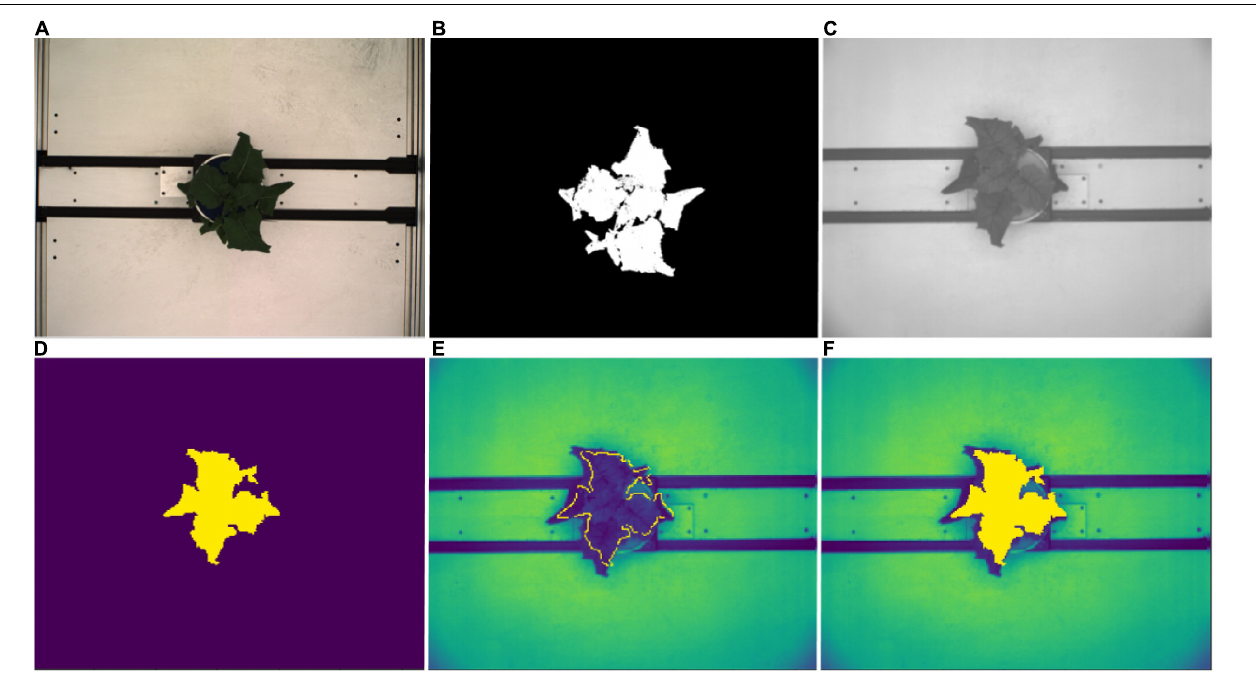
FIGURE 3 | NIR image processing workflow. (A) Top view RGB image. (B) Corresponding image segmentation resulting from workflow described in Figure 2 . (C) Original top view NIR grayscale image. (D) Resized and rescaled RGB image segmentation used as an image mask for NIR image. (E) Segmented plant outline overlaying NIR image (yellow boundary). (F) Segmented plant area overlaying NIR image (yellow